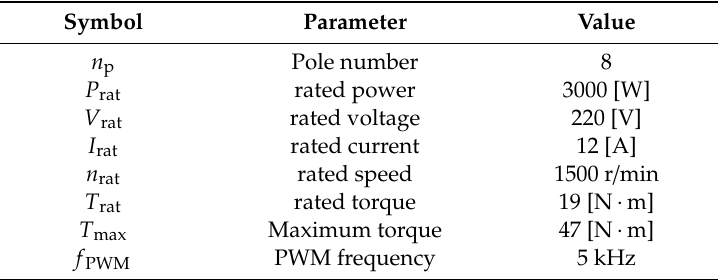
Table 3. Permanent magnet synchronous motor parameters.